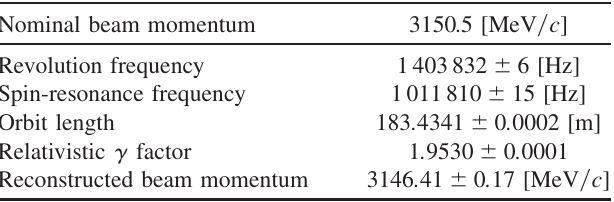
TABLE III. Typical results for one beam setting. Nominal beam